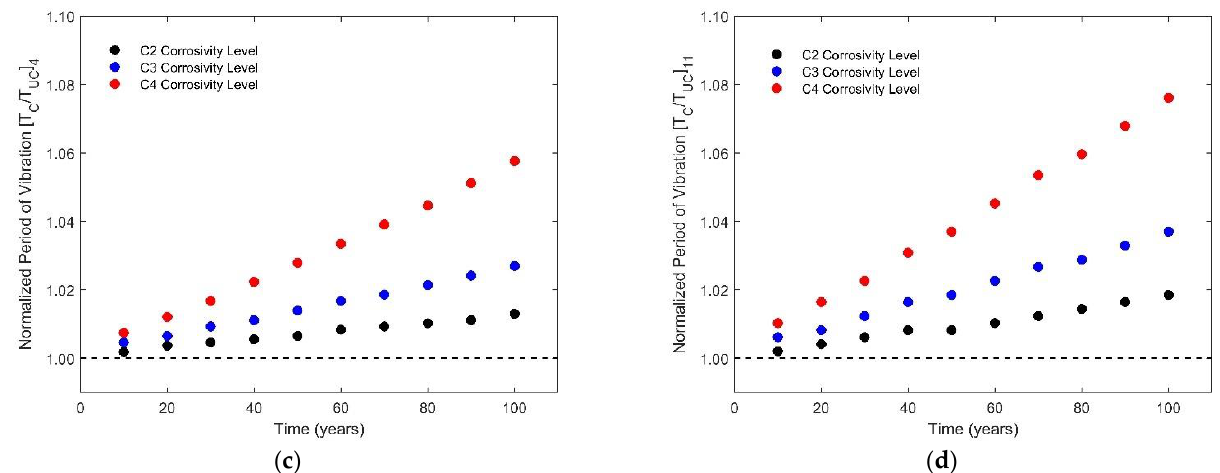
Figure 9. Normalized period of vibration respect to exposure time (effect of corrosion on flanges only) for: ( a ) mode no. 3 in Y direction; ( b ) mode no. 12 in Y direction; ( c ) mode no. 4 in X direction; ( d ) mode no. 11 in X direction. (T C and T UC are for corroded and uncorroded cases respectively).